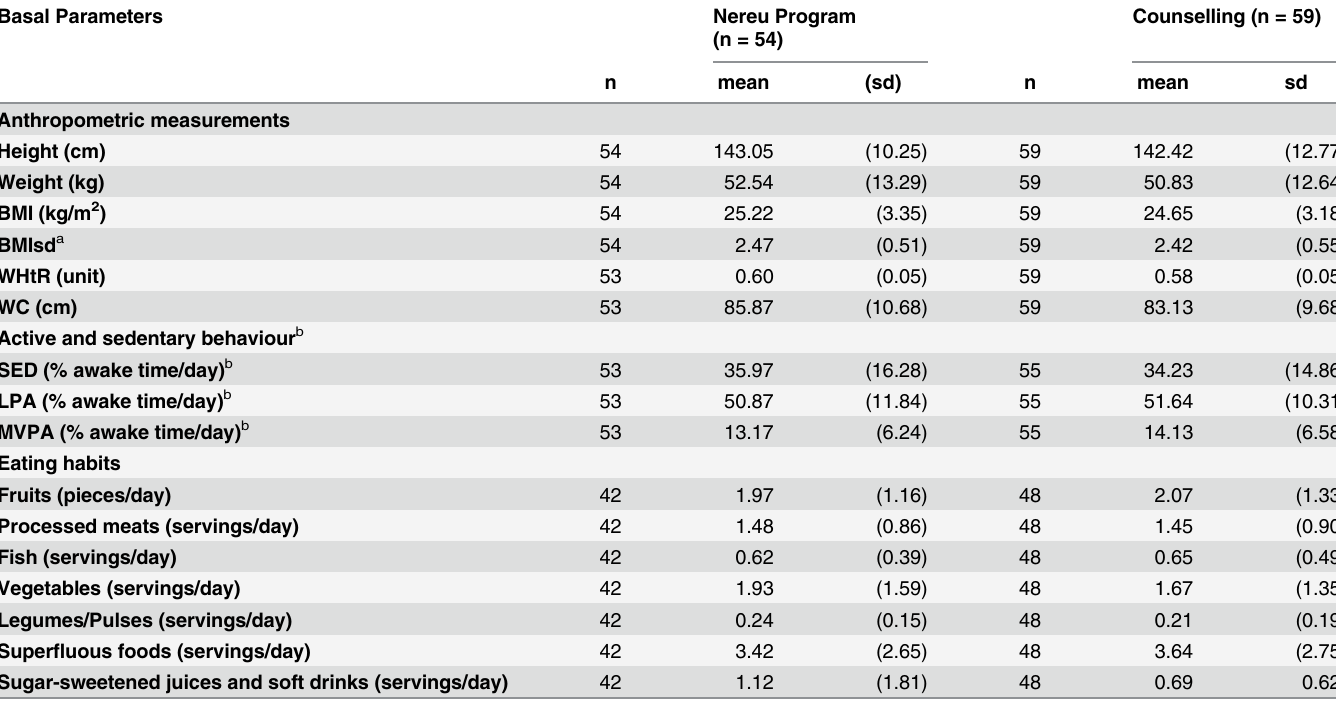
Table 1. Baseline Measurements of the Nereu Program (NP) and Counselling Group (CG). Basal